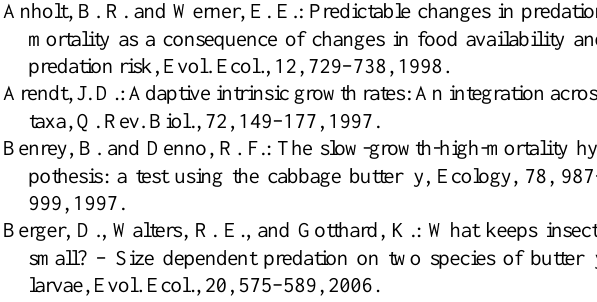
Values are Mean ± SE; ∗ indicates F-values to be significant at P < 0 . 001, respectively; NS indicates F-values to be non-significant at P > 0 . 05; Values followed by similar alphabets denote lack of significance at P > 0 .